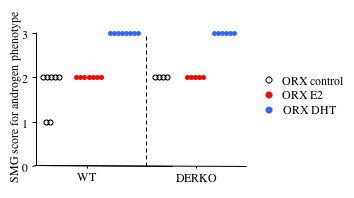
DHT increases the score for androgen phenotype in submandibular glands independently of estrogen receptors. 9-month-old male WT and DERKO mice were orchidectomized and treated for 4 weeks with E2 (0.05 μg/day) or DHT (44 μg/day), administered by s.c. silastic implants. Vehicle animals received empty implants. E2-treatment did not affect the androgen phenotype of SMG in either WT or DERKO mice. The SMG score for androgen phenotype was increased in DHT treated mice of both WT and DERKO genotype.